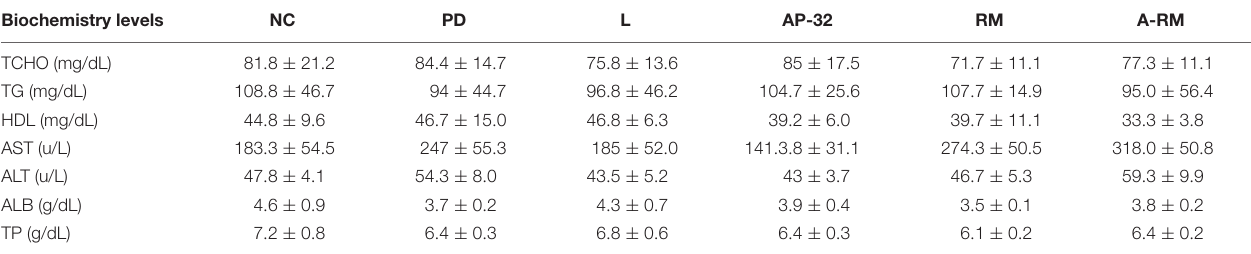
TABLE 1 | The effects of AP-32, RM, and A-RM on serum biochemical profiles after 8 weeks of treatment in 6-OHDA-induced PD rats. Biochemistry